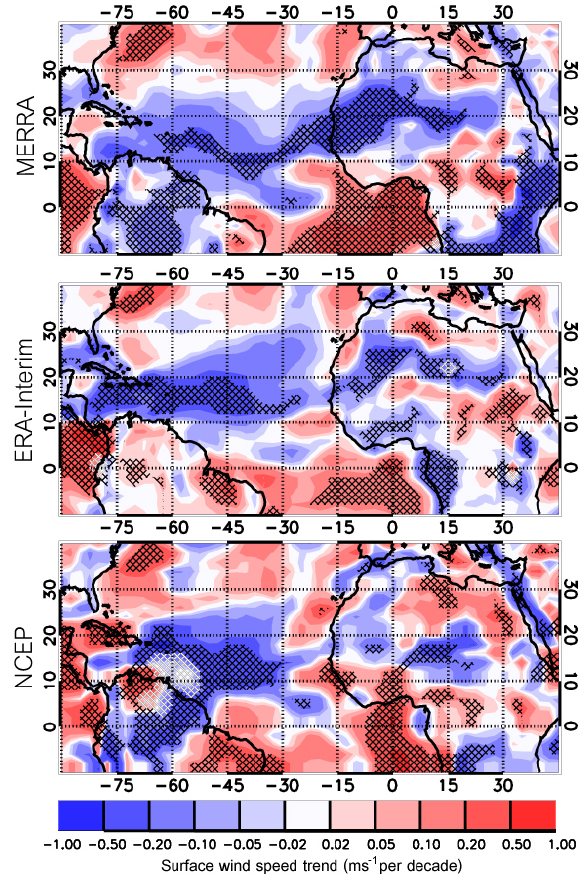
Figure 8. Spatial maps of the annual trend in surface winds between 1982 and 2008 based upon the averaged winds from MERRA, ERA-Interim and NCEP/NCAR reanalysis. Regions with trends that are significant at the 95% level are indicated with hashing.